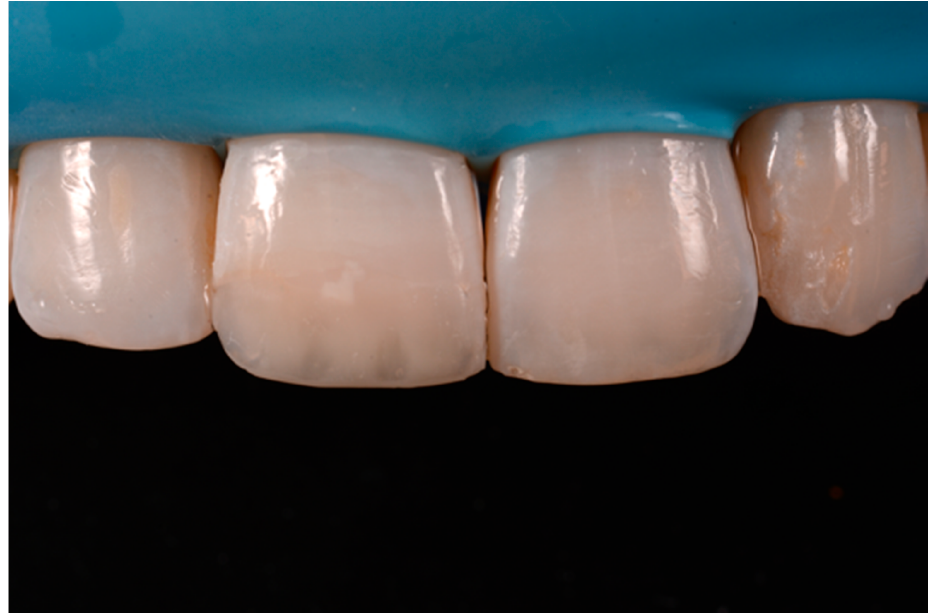
Figure 56. Translucent shade is applied, finishing and polishing performed.